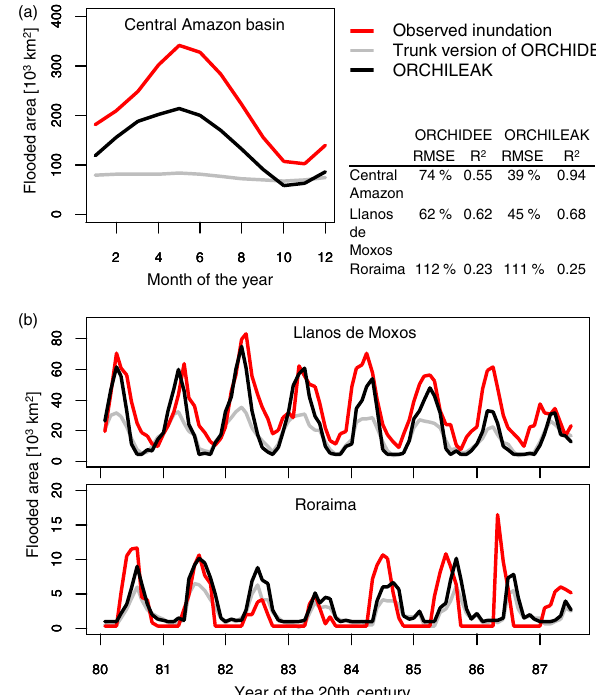
Figure 8. Simulated versus observed flooded area in the Ama- zon basin. (a) Central Amazon basin. Observed data from Richey et al. (2002) after Hess et al. (2003). Inundation corresponds to the sum of water surfaces of main channel, tributaries and flood- plains recorded during the period October 1995 to September 1996. (b) Llanos de Moxos and Roraima floodplains over the period Jan- uary 1980 to September 1987. Observed data from Hamilton et al. (2011). RMSE is expressed as relative to the mean observed value per